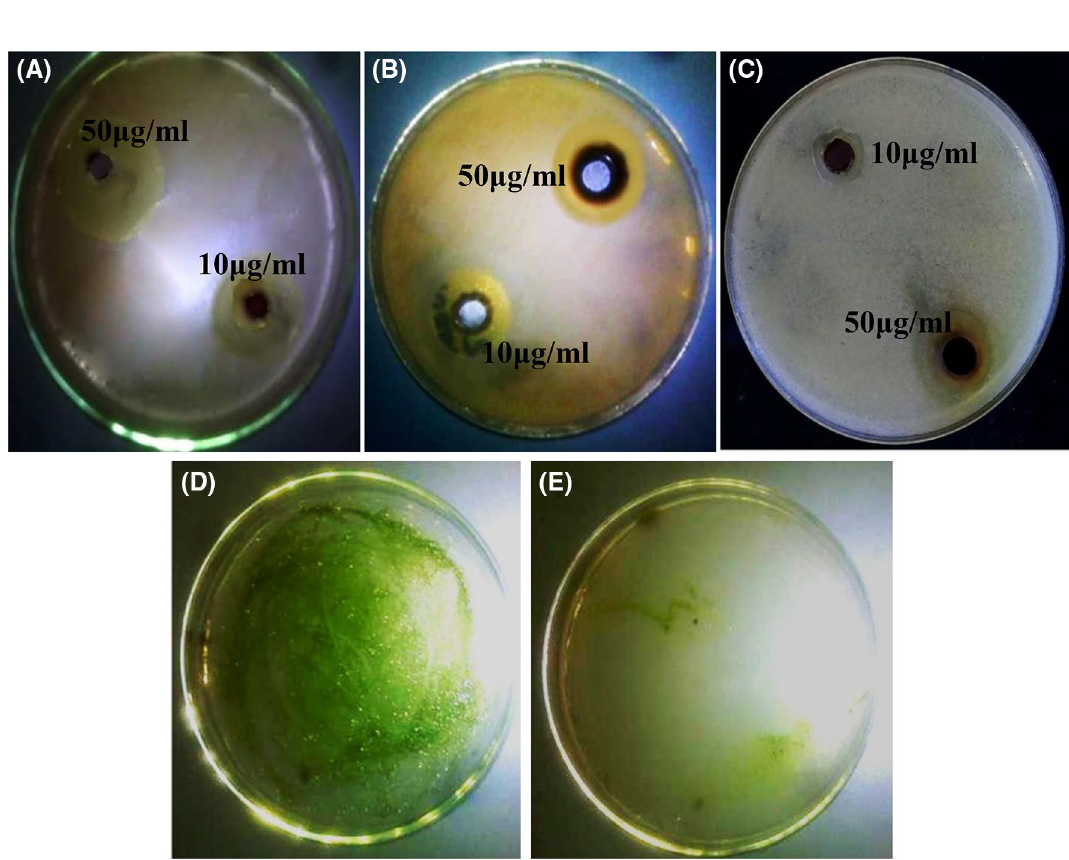
Figure 7. Antimicrobial activity of different concentrations of Ag@Ag 2 O NCs against E. coli ( A ), B. cereus ( B ) and C. albicans ( C ) as representative models of pathogenic Gram-negative bacteria, Gram-positive bacteria and Fungi, respectively. ( D ) C. vulgaris control before treatment with Ag@Ag 2 O NCs and ( E ) C. vulgaris after treatment with 50 μg/ml of Ag@Ag 2 O